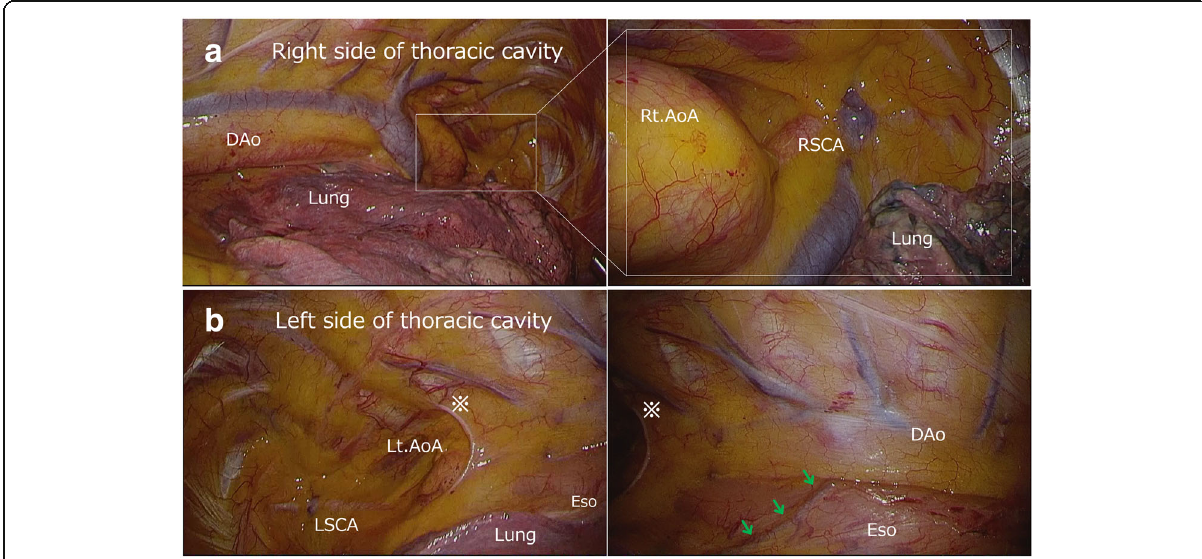
Fig. 4. a Intraoperative findings from the right side of the thoracic cavity. The superior right aortic arch and right side of the descending aorta obscured the esophagus and interfered with the normal right thoracic approach. b Intraoperative findings from the left side of the thoracic cavity. We were able to approach the esophagus just below the left aortic arch but could not approach the upper mediastinum or the right side. Postmediastinal reconstruction seemed impossible. Green arrows indicate the left bronchial artery. DAo, descending aorta; Eso, esophagus; Lt./Rt. AoA, left/right aortic arch; LSCA/RSCA, left/right subclavian